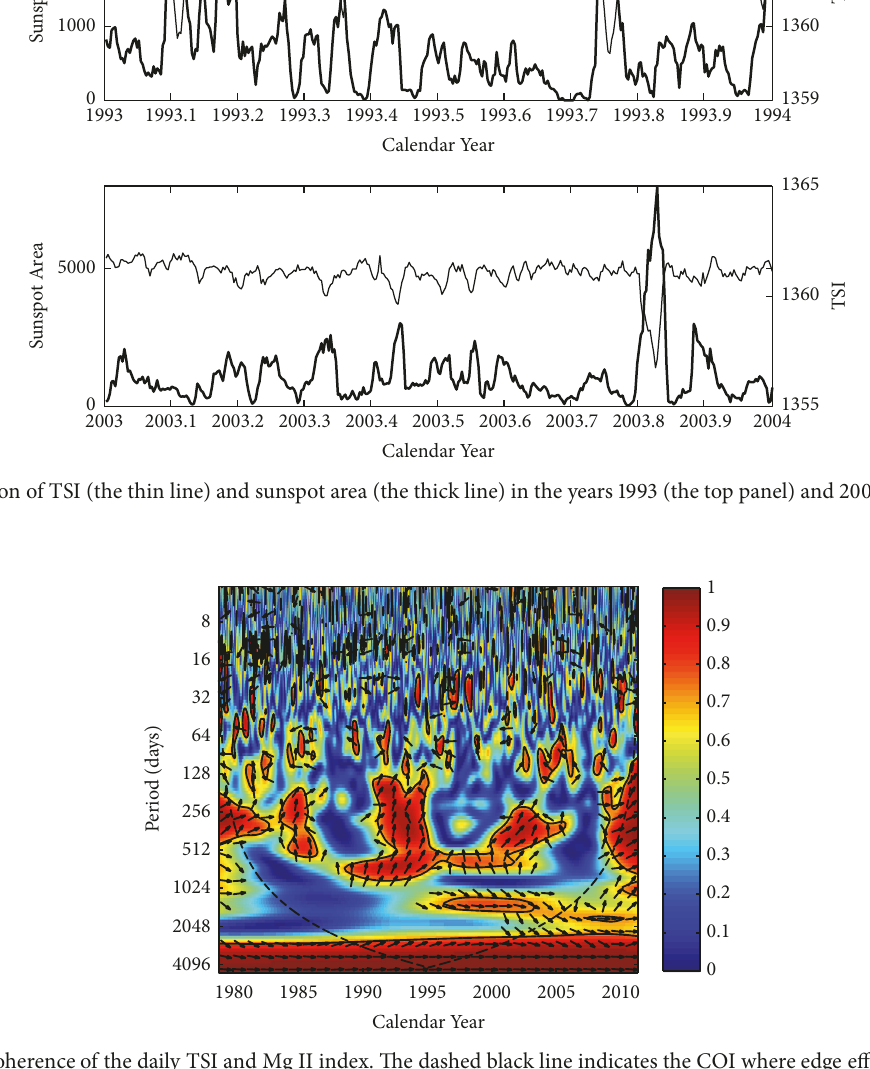
Figure 5: Wavelet coherence of the daily TSI and Mg II index. The dashed black line indicates the COI where edge effects might distort the picture, and the 95% confidence level is shown as a thick contour, which is estimated by Monte Carlo method. The relative phase relation is shown as arrows (with in-phase pointing right, antiphase pointing left, and TSI leading Mg II index by 90 ∘ pointing straight